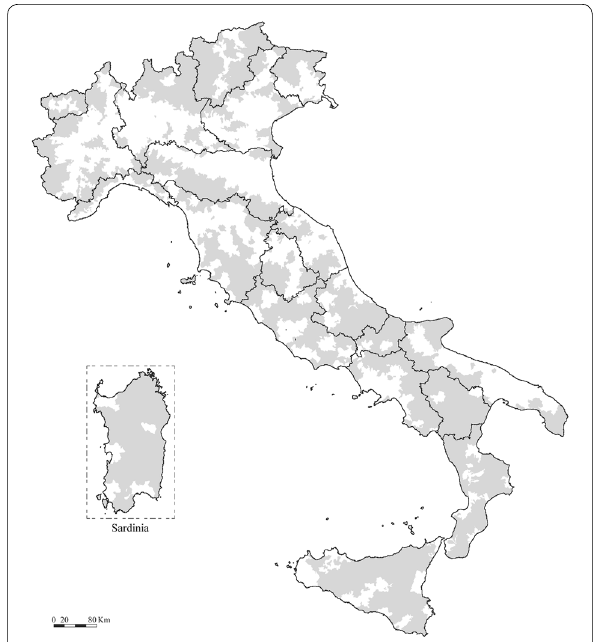
Fig. 1 Italian inner areas (in grey) (Source: Elaboration from data processed by UVAL